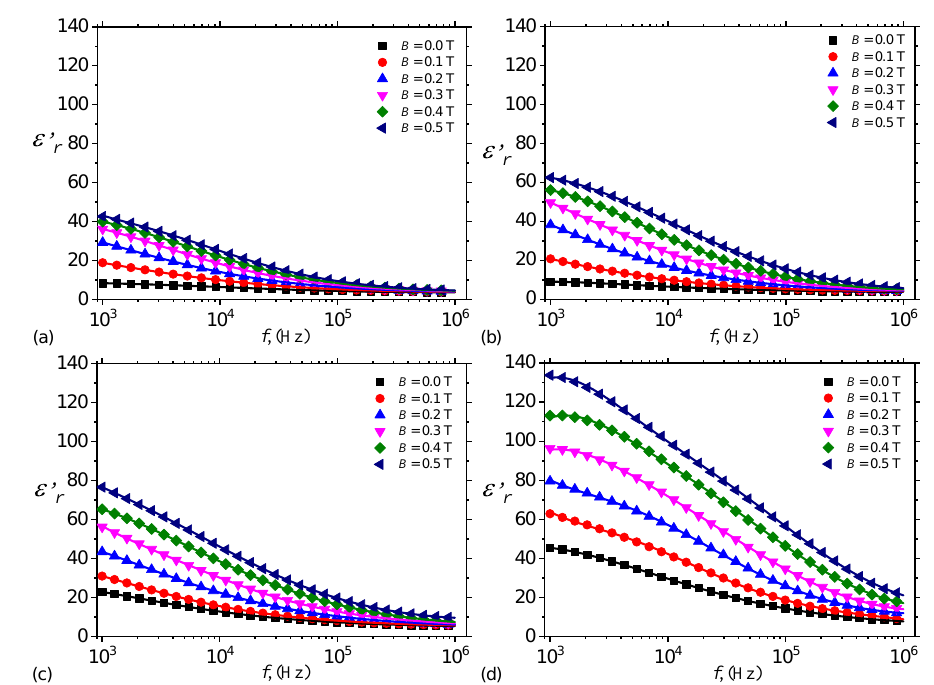
Figure 7. Variation of relative dielectric permittivity (cid:101) (cid:48) r with frequency f , at fixed values of magnetic flux density B . ( a ) hMAC. ( b ) hEMAC 1 . ( c ) hEMAC 2 . ( d ) hEMAC 3 .